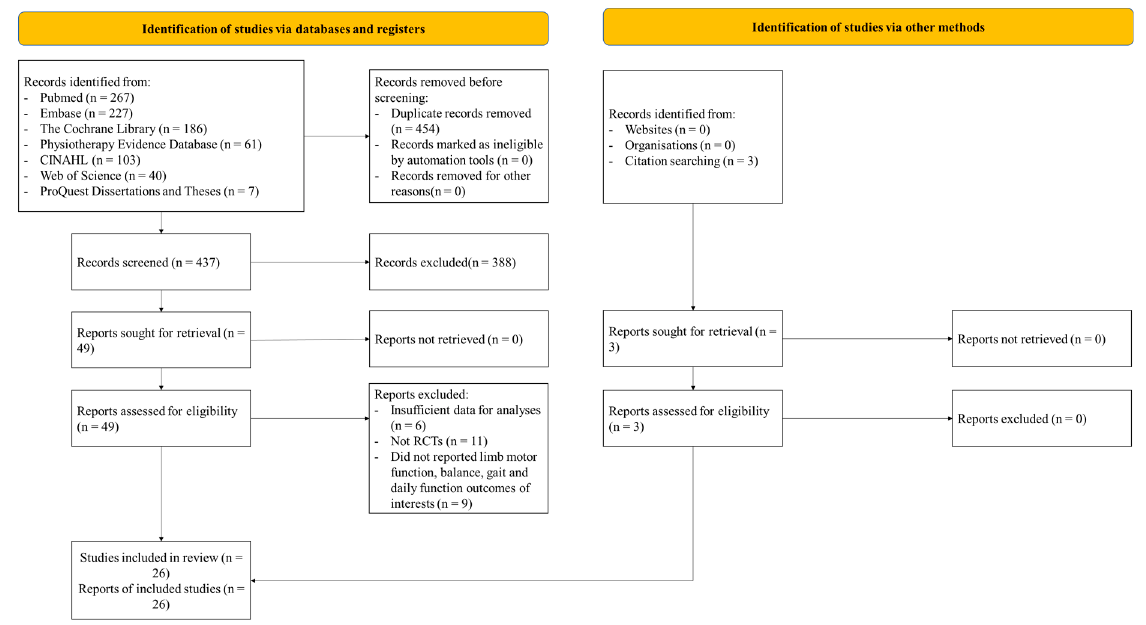
Figure 1. Flow diagram of literature screening.